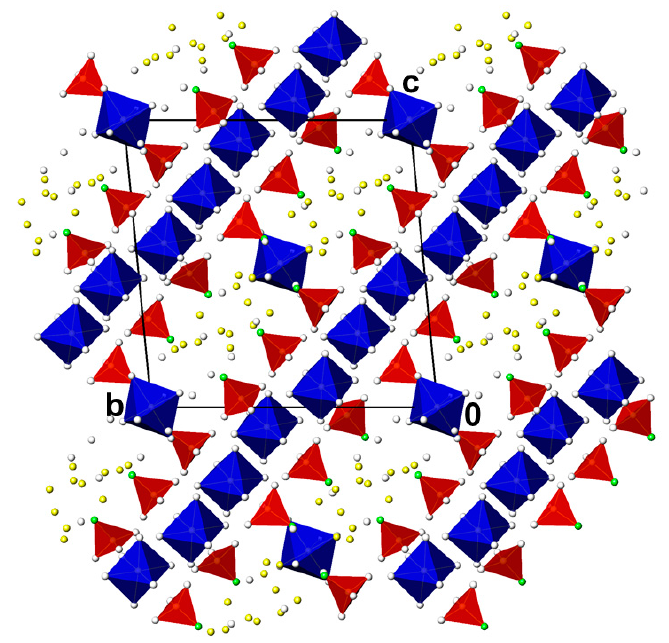
Figure 3. The crystal structure of Cr 2 (PO 3 F) 3 (H 2 O) 18.8 in a projection along [- 100]. Colour code of PO 3 F tetrahedra as in Figure 1; [CrO 6 ] octahedra are given in blue, O atoms of crystal water molecules with full occupation are given as colourless spheres and those of disordered crystal water molecules as yellow spheres. For clarity, disorder of one of the PO 3 F groups is not shown.